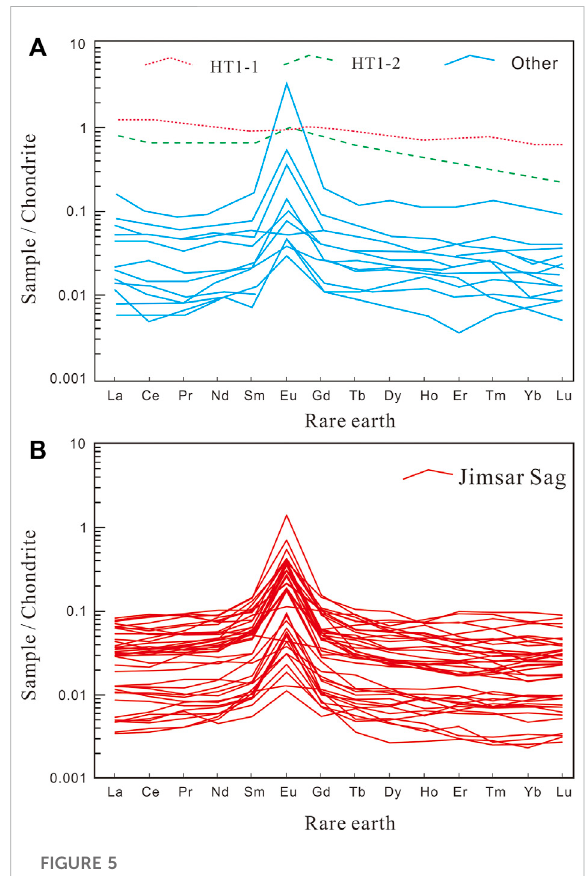
FIGURE 5 Rare earth element distributions of (A) Ordovician calcite in Tazhong of Tarim Basin, and (B) Lucaogou Formation Permian calcite of Jimsar